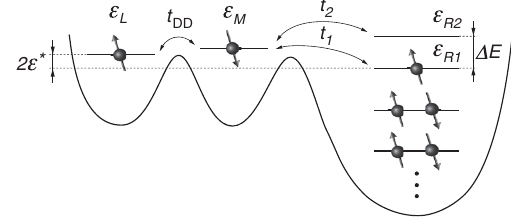
FIG. 6. Schematic of a two-electron double quantum dot coupled to an odd-occupied spin- 1 = 2 multielectron dot. Symbols ε indicate single-particle energies of the lowest orbitals L=M=R 1 =R 2 in the double dot and the two lowest orbitals above the effective vacuum in the multielectron dot. Arrows indicate tunnel cou- plings between the left and middle orbital ( t ) and between the DD middle orbital and each of the two orbitals in the multielectron dot ( t 1 ). The single-particle energy difference between the two = 2 − ε orbitals on the multielectron dot is indicated by Δ E ¼ ε . R 2 R 1 − ε Þ = 2 is varied when calculating the Detuning ε (cid:2) ¼ ð ε L R 1 energy diagram and leakage spectrum presented in Figs. 7(b), 7(e), 9(b), and 9(e). Within the range of relevant parameters, low- lying orbitals in the right dot remain doubly occupied (i.e., spinless) and can be ignored when solving Eq. (3), thereby yielding a three-electron Hubbard model. [Similarly, a four- electron Hubbard model is solved to model the spin-1 case in Figs. 13(b) and